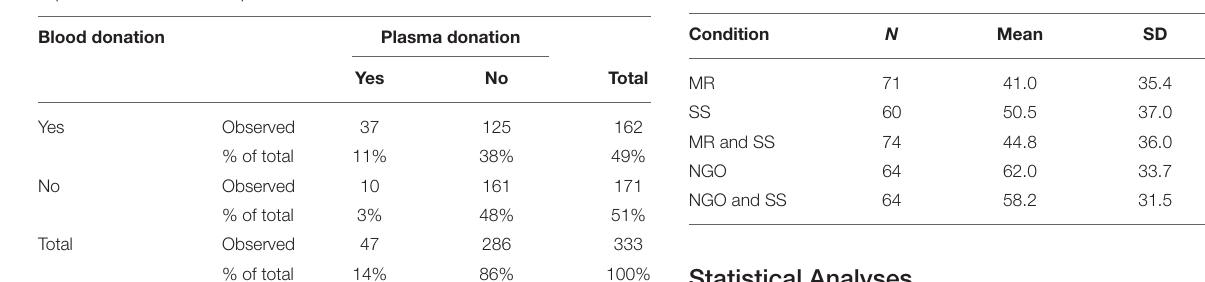
TABLE 3 | Group descriptives of the donation willingness scores in the five conditions used in the